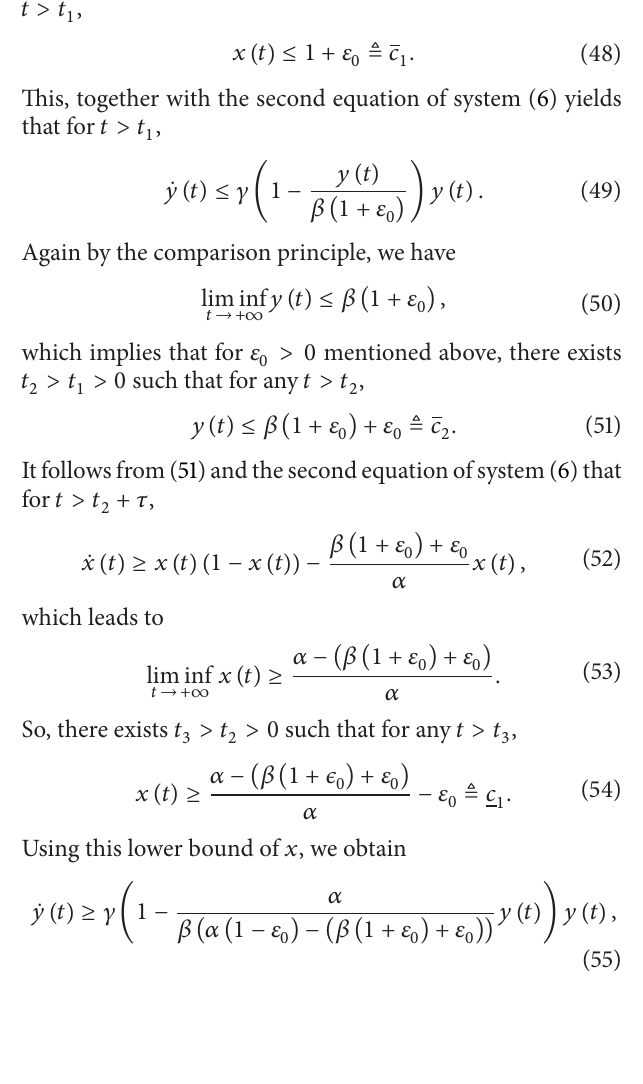
any 𝜏 ≥ 0 , and system (6) undergoes Hopf